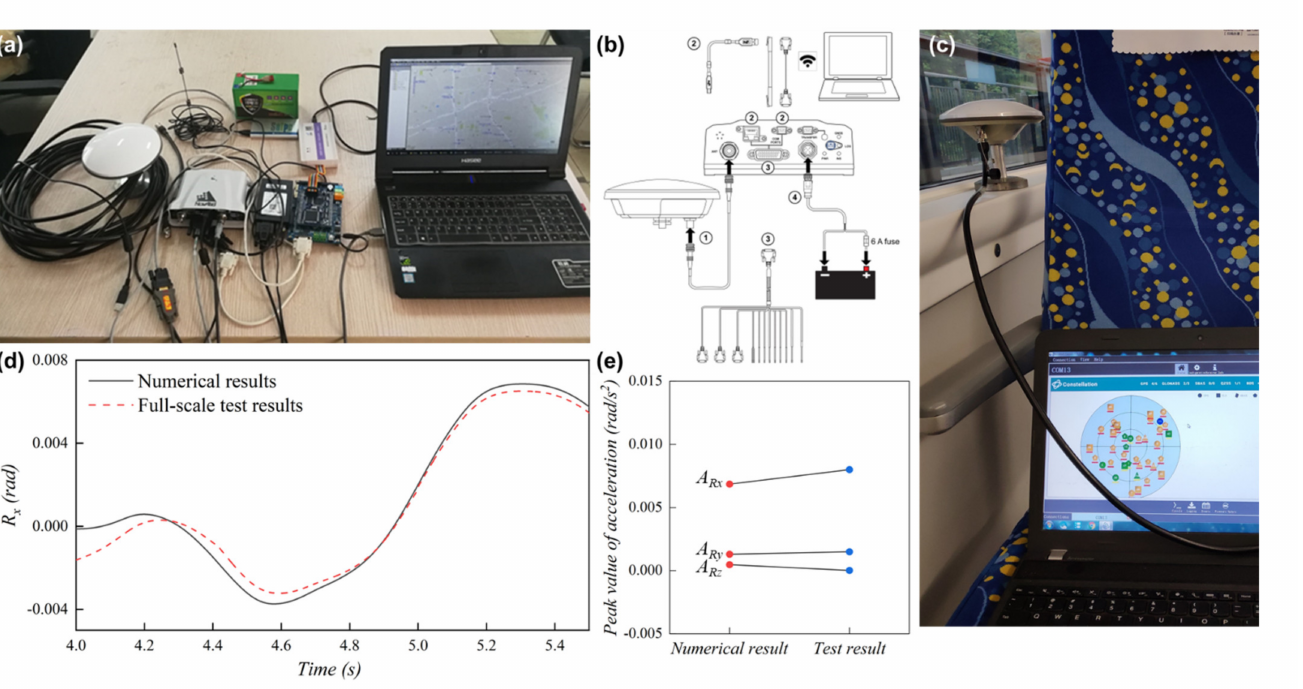
Figure 6. The validation of the numerical method: ( a ) the entire PP7-E1 system; ( b ) the schematic diagram of PP7-E1 system; ( c ) the measuring setup in the car; ( d ) the rolling rotation obtained by numerical simulation and test; ( e ) the maximum value of the rotation acceleration obtained by numerical simulation and